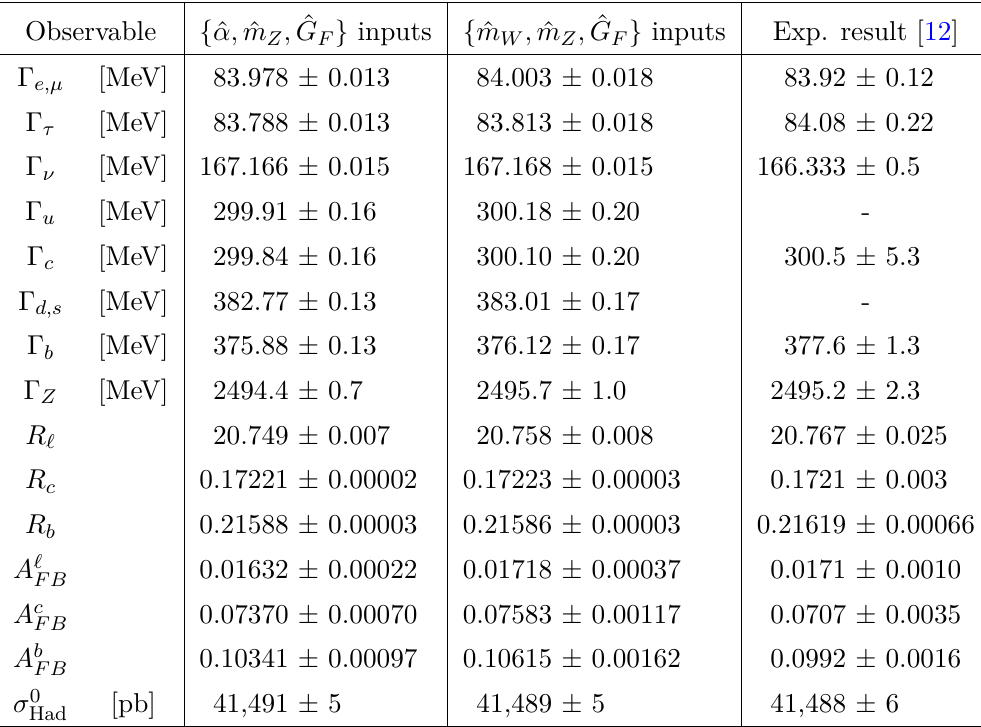
Table 1 . Predictions for LEPI observables in the two input parameter schemes. The { ˆ m W , ˆ m Z , ˆ G F } scheme results are derived using [40–43]. In particular A c